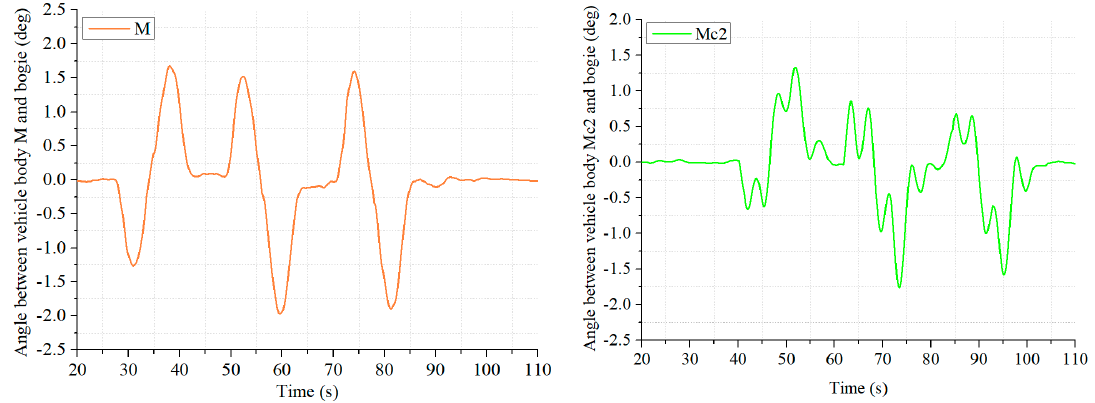
Figure 8. Angle between vehicle and bogie with hydraulic anti-kink system.